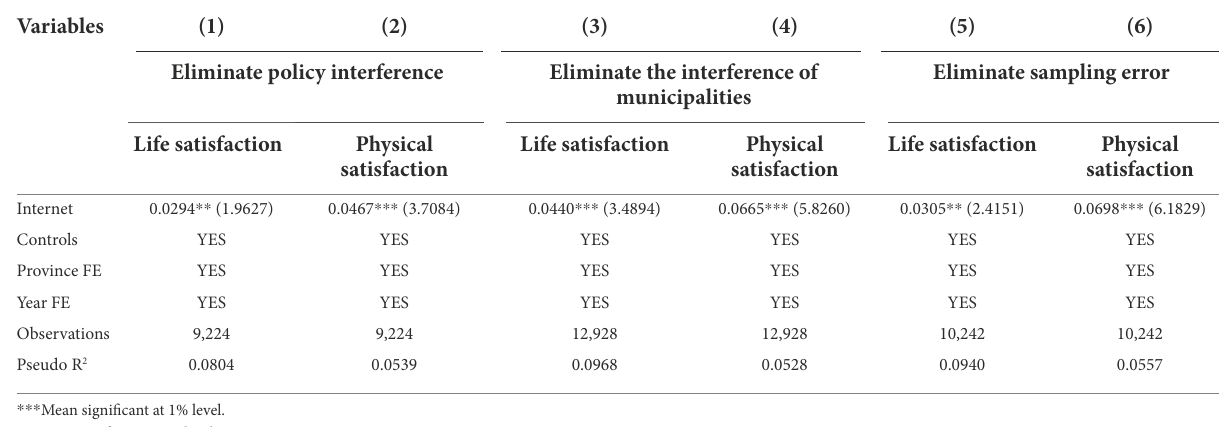
TABLE 5 Other robustness tests.